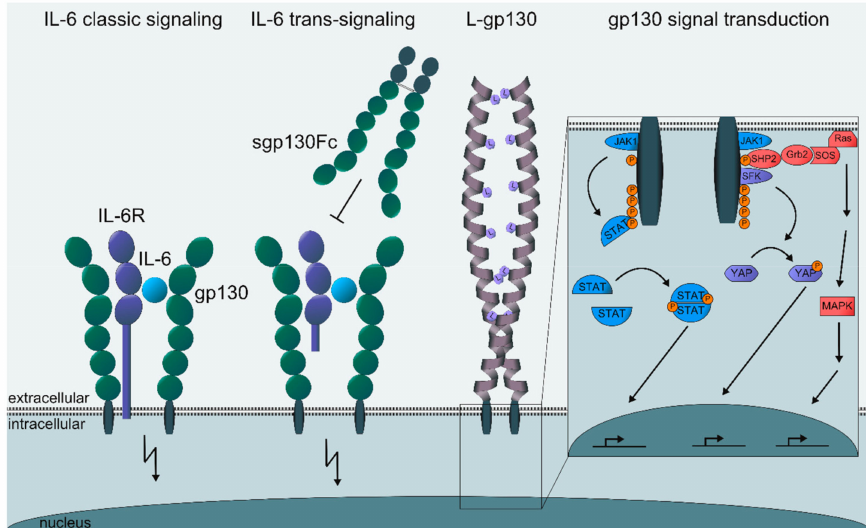
Figure 1. Modes of IL-6 signaling. IL-6 can signal via the membrane-bound IL-6R, which, however, is only expressed on some cell types. Alternatively, IL-6 can bind to the soluble IL-6R (sIL-6R) and the complex of IL-6 / sIL-6R can stimulate virtually all cells in the body since gp130 is ubiquitously expressed. In an artificial model of cell-autonomous gp130 stimulation, the extracellular portion of gp130 has been exchanged for a leucine zipper, leading to constitutive gp130 signaling in the absence of any ligand [6]. The insert shows the main intracellular signaling pathways stimulated by gp130